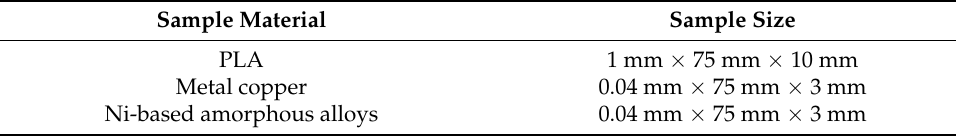
Figure 8. Schematic diagram of the sample used for deformation recovery test. Table 5. Sample material and size .